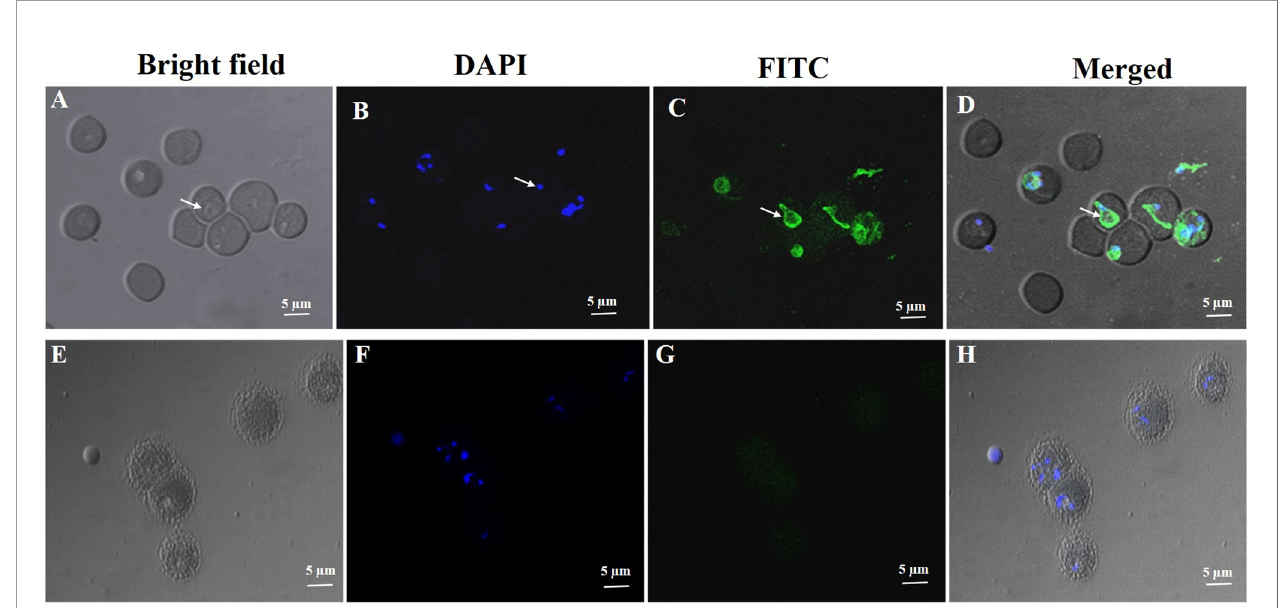
FIGURE 3 | Immuno fl uorescent localization of BmRON2 in intraerythrocytic B. microti. The anti-r BmRON2 antibody reacts with native BmRON2 in the cytoplasm of B . microti , indicating that BmRON2 is localized at the apical end of the merozoite. White arrows in images (A – D) show RBCs infected with B. microti parasites. Nuclei are stained blue with 6-diamidino-2-phenylindole (DAPI) (B) , and BmRON2 is stained green (C, D) , indicating reactivity with the FITC — labelled anti-rabbit IgG and anti-rBmRON2 antibodies. Red blood cells of uninfected mice did not show any speci fi c fl uorescent signals (E – H) . Scale bar represents 5